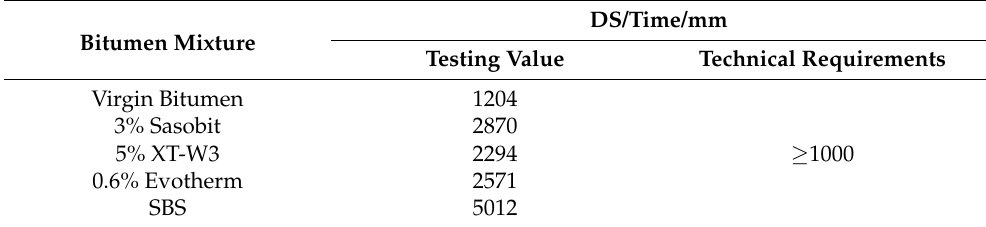
Table 7. Results of the high-temperature rutting test.